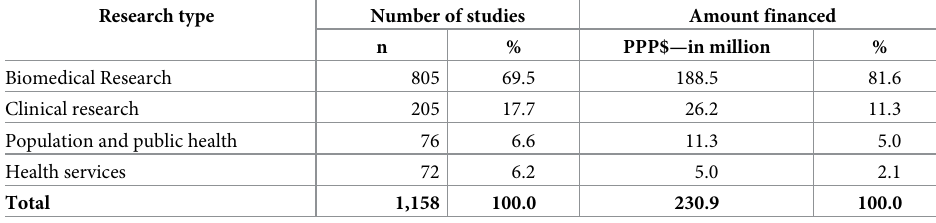
Table 2. Distribution of research funding on neglected tropical diseases by type of research. Brazil,